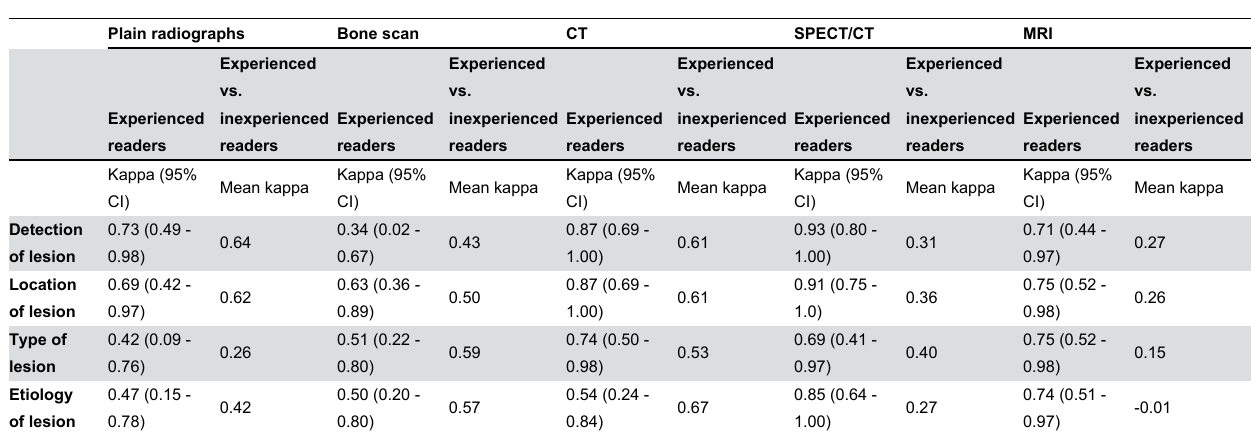
Table 4. Kappa of agreement between experienced readers, and between experienced and inexperienced readers.